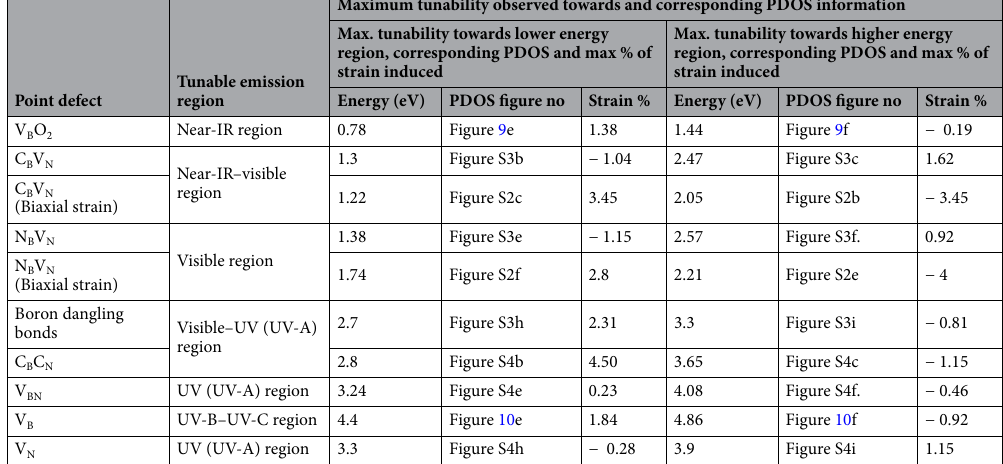
Table 5. Information related to feasible tunability region, PDOS of strained quantum emitters and % of strain induced. *S1 and S2 indicates supporting information Figs. 1 and 2, respectively. Point to be noted is that the positive and negative strain % values in the Table 5 indicates positive and negative biaxial strains (in case of biaxial strain inducements). In case of, one-sided lateral and longitudinal strain inducements the positive strain values create tensile effects and negative strain values creates compression effects.